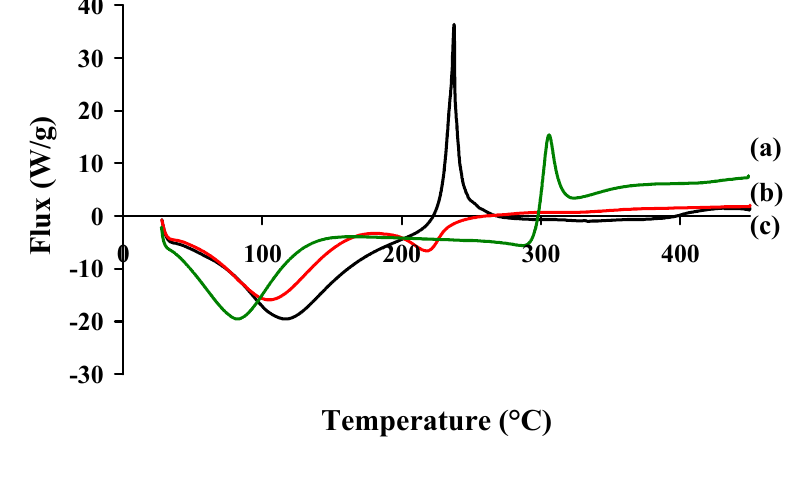
Figure 7. DSC profiles of ( a ) CS, ( b ) CS-HA PEC complex and ( c )